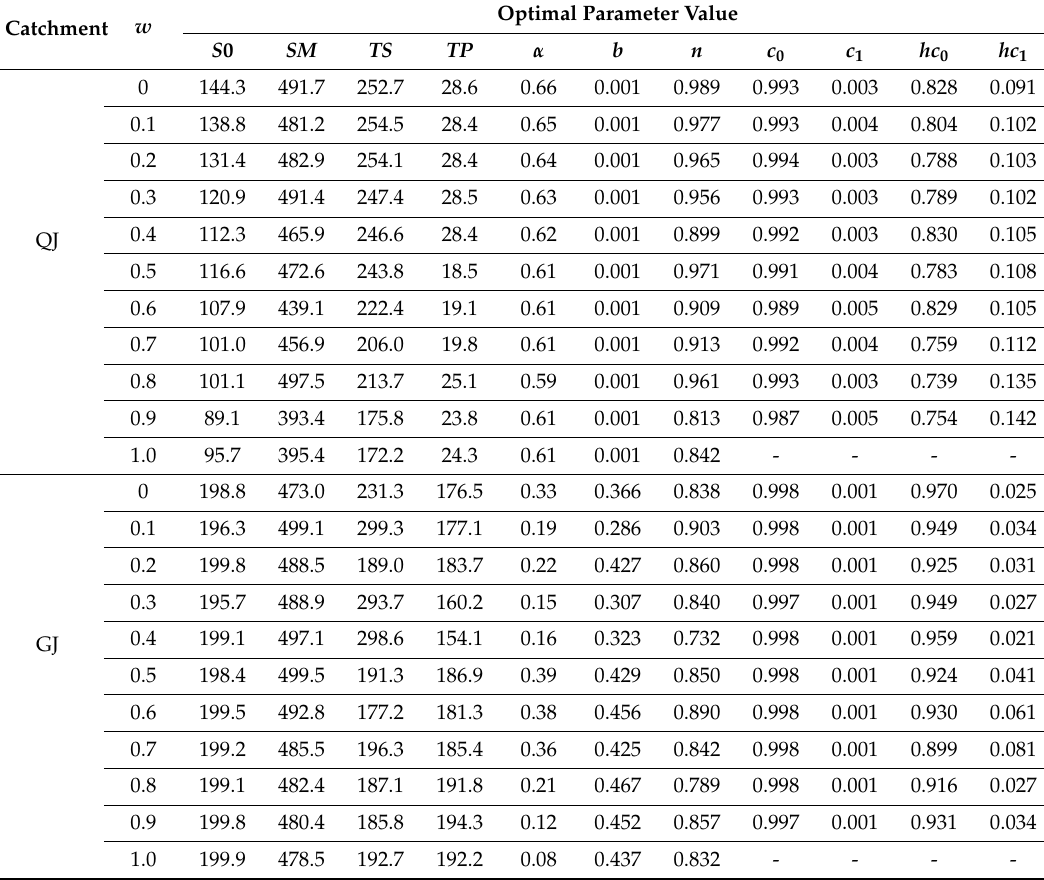
Table 3. Optimal parameter values under 11 calibration schemes for QJ and